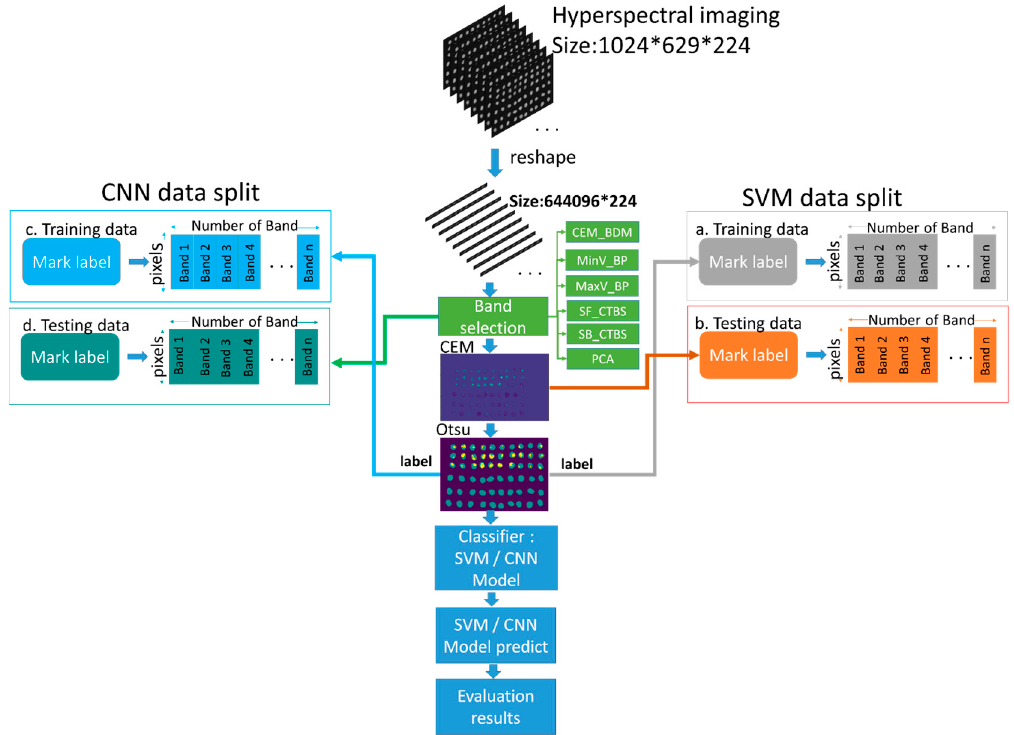
Figure 9. The hyperspectral insect damage detection algorithm flowchart. ( a ) Training data of Support Vector Machine (SVM), ( b ) Testing data of Support Vector Machine (SVM), ( c ) Training data of